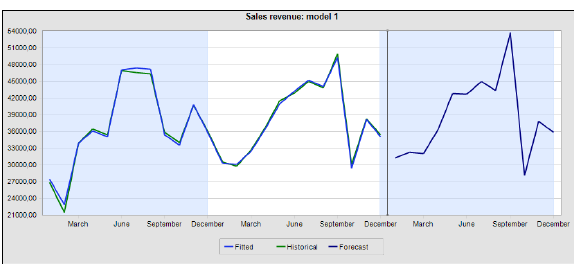
Figure 4: Forecast diagram of variable sales revenue: model 1.